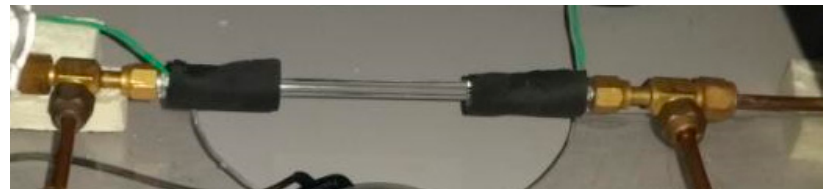
Figure 2. Overview of the measuring section 12.